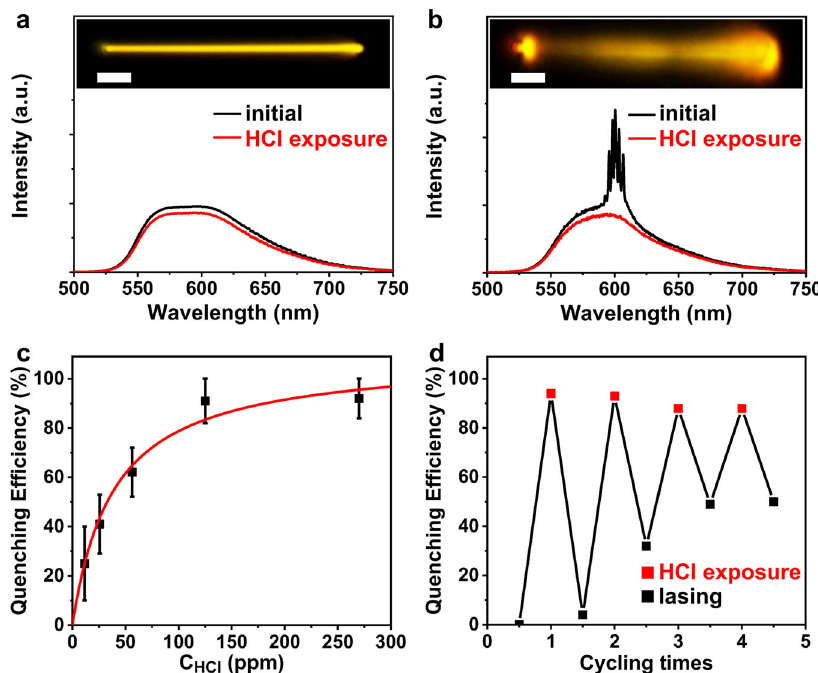
Fig. 4 Sensing properties of BPCBT microwires to HCl vapor. a Photoluminescence and b lasing spectra of BPCBT microwires before and after exposure to HCl vapor. Insets are optical microscopy images of microwires. Scale bars are 5 μ m. c Quenching ef fi ciency of lasing from a BPCBT microwire upon exposure to HCl vapor with different concentrations. Error bars represent the deviation of three measurements. d Cycles of lasing quenching and recovery from a BPCBT microwire upon exposure to HCl vapor and air with 10 min intervals at constant pump energy.